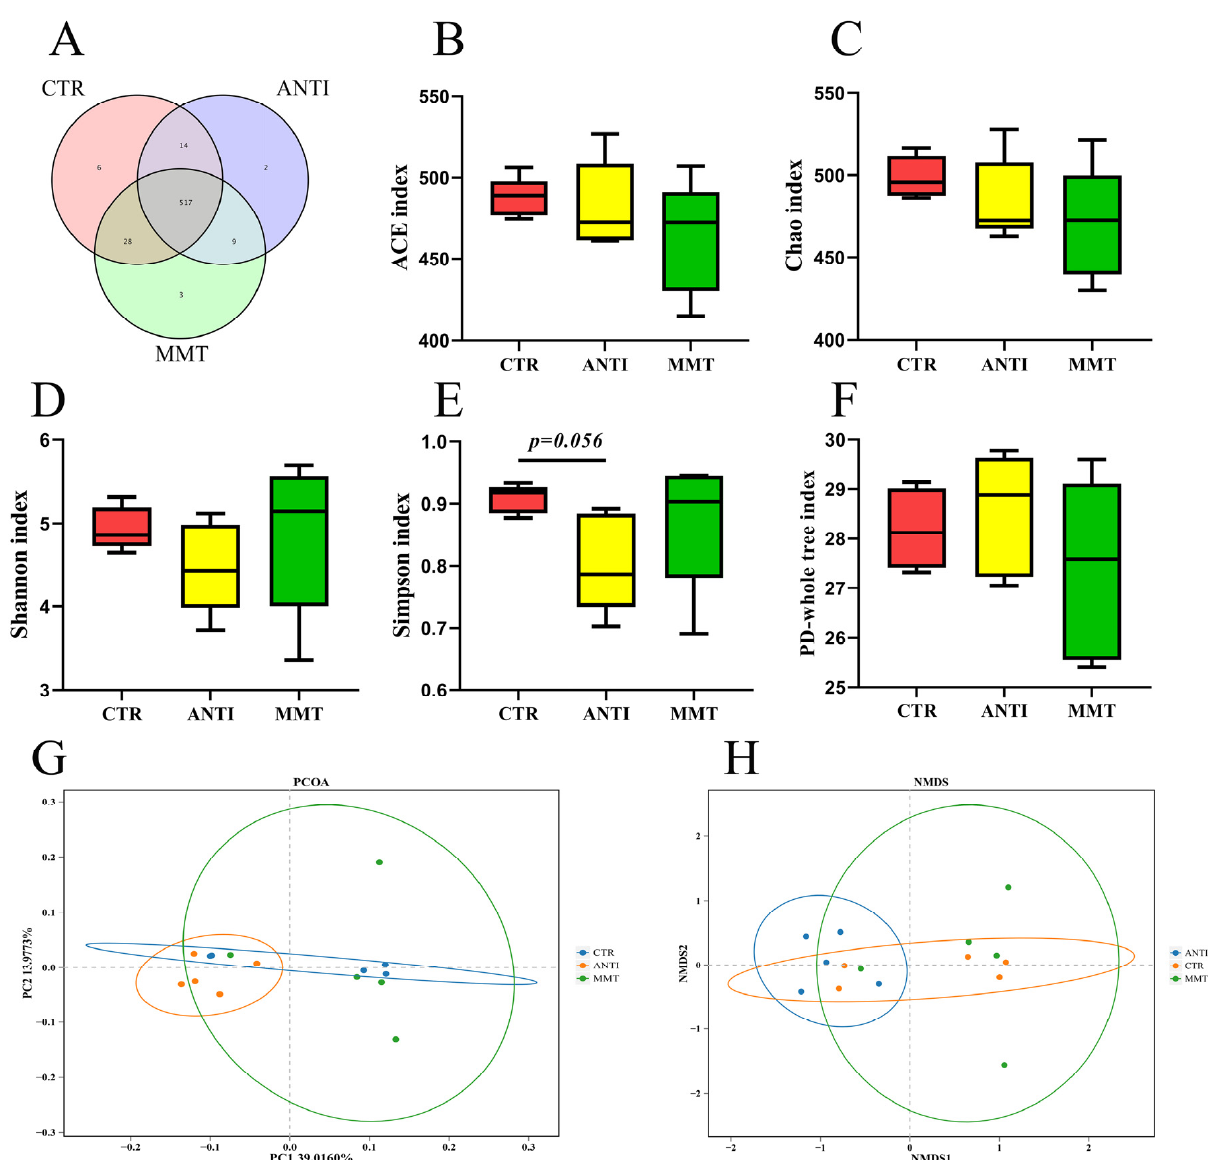
Figure 1. Effect of MMT on gut microbiota diversities of broilers: ( A ) Venn diagram; ( B ) ACE index; ( C ) Chao1 index; ( D ) Shannon index; ( E ) Simpson index; ( F ) PD-whole tree; ( G ) Principal coordinate analysis (PCoA)analysis of weighted UniFrac distance; ( H ) NMDS analysis of weighted UniFrac distance. Data are presented as means ± SD (n = 5)